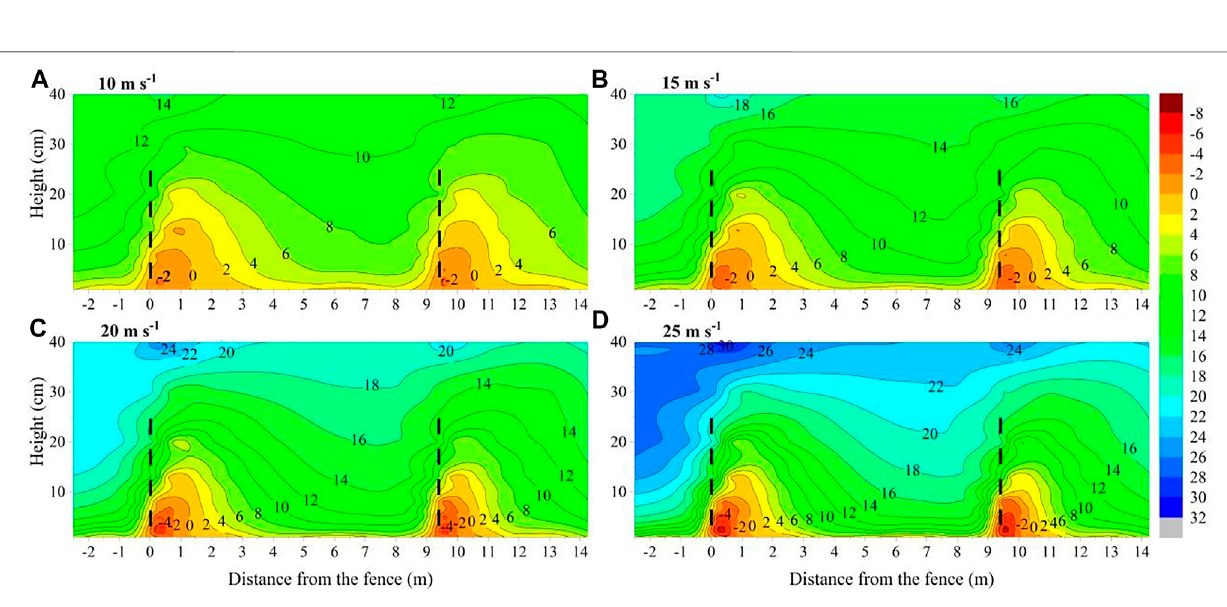
Frontiers in Environmental Science |